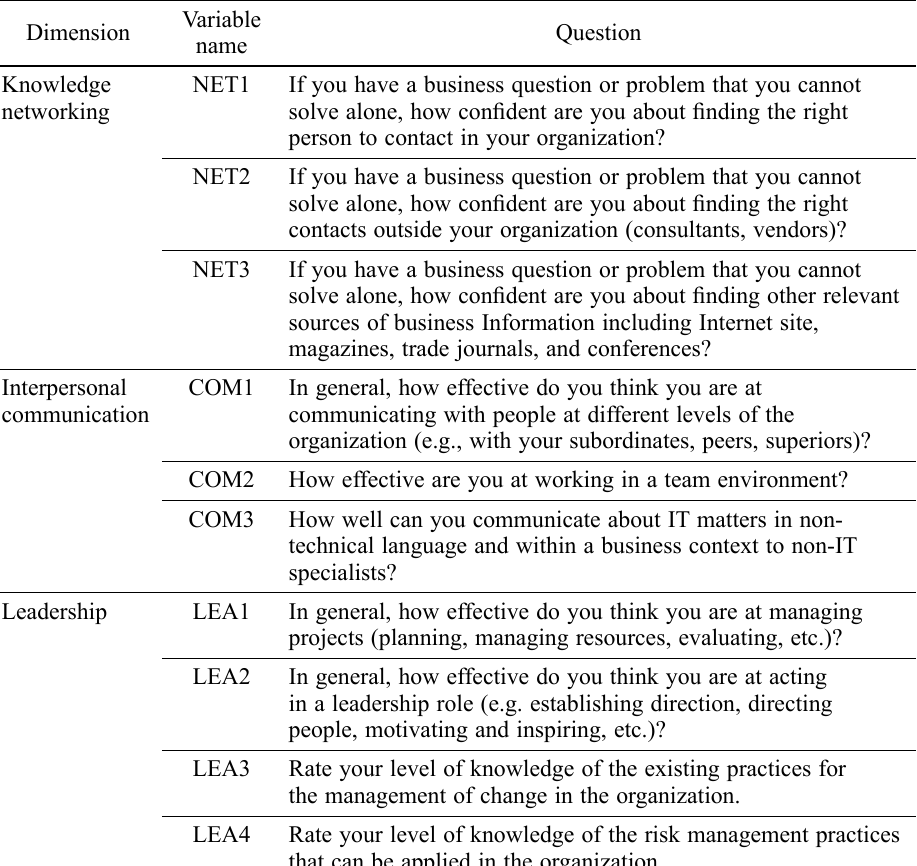
Table 3. Items for business competence regarding interpersonal and management knowledge (Adapted from Bassellier and Benbasat (2004)) Variable Dimension